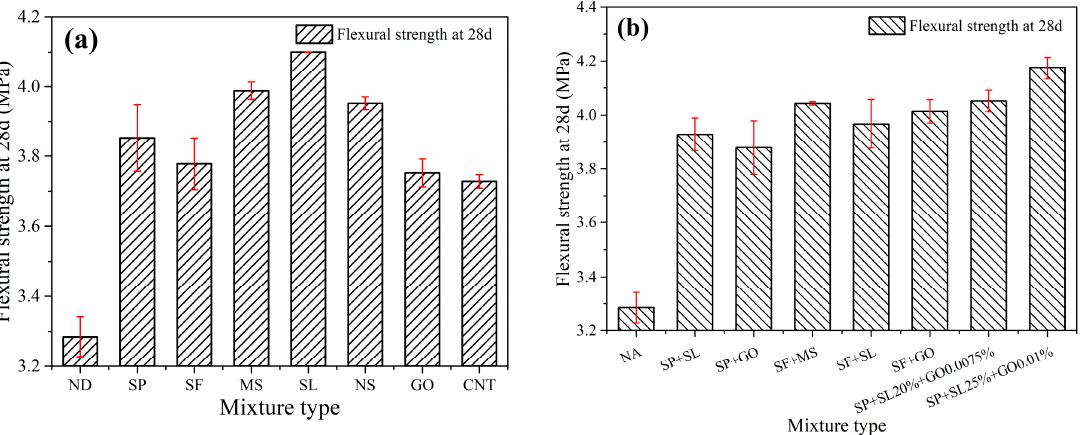
Figure 9. Effect of admixtures add on flexural strength of porous concrete: ( a ) specimen with single admixtures; ( b ) specimen with composite admixtures.